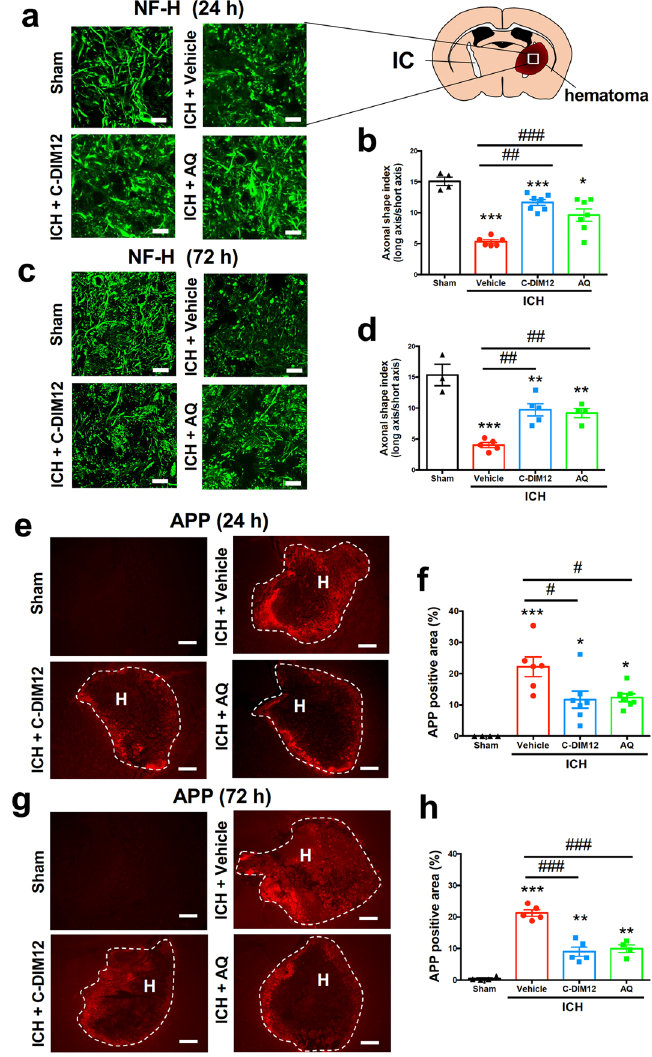
Figure 4. Effects of C-DIM12 and amodiaquine on axonal integrity after ICH. C-DIM12 (50 mg/kg, p.o.), amodiaquine (AQ; 40 mg/kg, i.p.) or vehicle (p.o. or i.p.) was administered at 3, 27 and 51 h after ICH induction. ( a ) NF-H-immunopositive axons in the internal capsule (IC) at 24 h after ICH. Scale bars = 20 μm. ( b ) Quantitative results of axon fragmentation at 24 h. Number of mice was 4 in sham group, 6 in ICH + vehicle group, 7 in ICH + C-DIM12 group and 7 in ICH + AQ group, respectively. ( c ) NF-H-immunopositive axons at 72 h after ICH. Scale bars = 20 μm. ( d ) Quantitative results of axon fragmentation at 72 h. Number of mice was 3 in sham group, 5 in ICH + vehicle group, 5 in ICH + C-DIM12 group and 4 in ICH + AQ group, respectively. ( e ) APP immunohistochemistry at 24 h after ICH. Scale bars = 500 μm. H; hematoma. ( f ) Quantitative results of APP-positive area at 24 h. Number of mice was 4 in sham group, 6 in ICH + vehicle group, 7 in ICH + C-DIM12 group and 7 in ICH + AQ group, respectively. ( g ) APP immunohistochemistry at 72 h after ICH. Scale bars = 500 μm. H; hematoma ( h ) Quantitative results of APP-positive area at 72 h. Number of mice was 4 in sham group, 5 in ICH + vehicle group, 5 in ICH + C-DIM12 group and 4 in ICH + AQ group, respectively. * P < 0.05, ** P < 0.01, *** P < 0.001 versus sham group, # P < 0.05, ## P < 0.01, ### P < 0.001 (ANOVA results: for b , F 3,20 = 28.79, P < 0.001; for d , F 3,13 = 22.36, P < 0.001; for f , F 3,20 = 11.74, P < 0.001; for h , F 3,14 = 56.61, P <